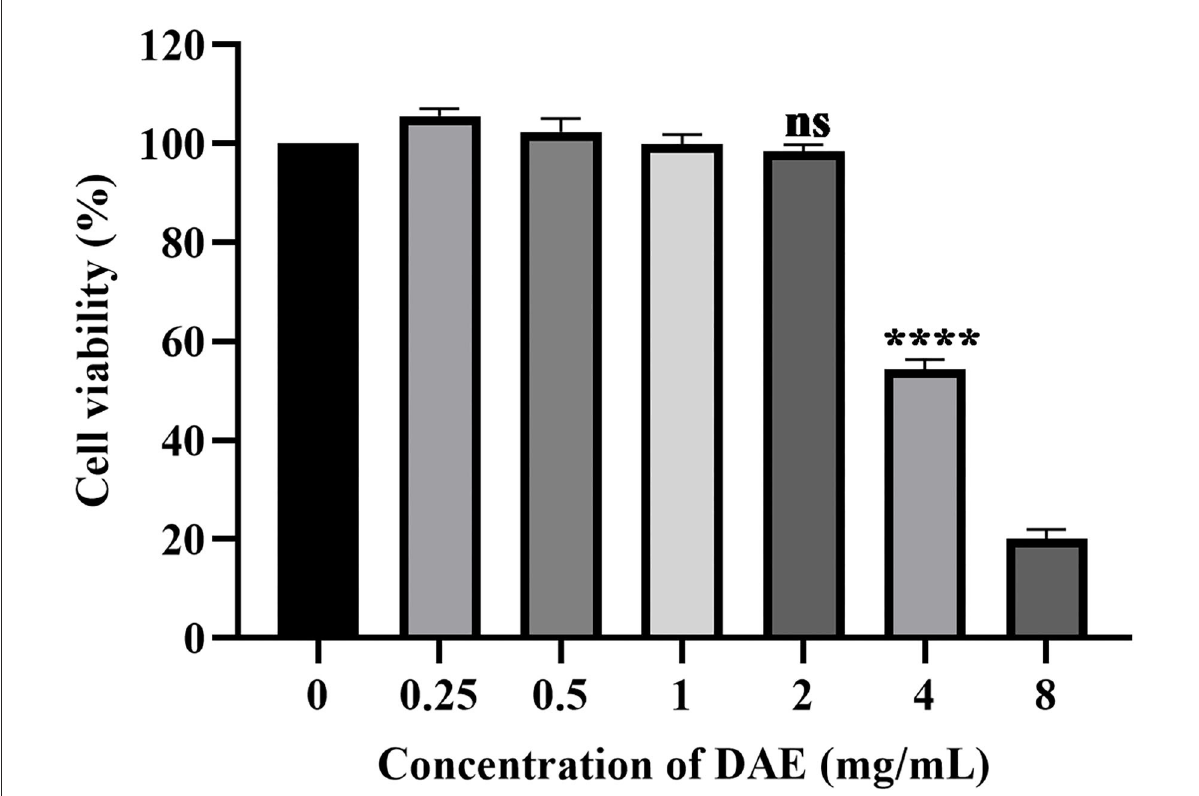
FIGURE1 Cytotoxicity of DAE at different concentrations in PK15 cells. A CCK8 assay was used to determine the toxicity of DAE to PK15 cells at concentrations of 8, 4, 2, 1, 0.5, and 0.25 mg/mL. The cell viability was expressed as a percentage of the control cell viability (**** P < 0.0001, ns: P > 0.05).